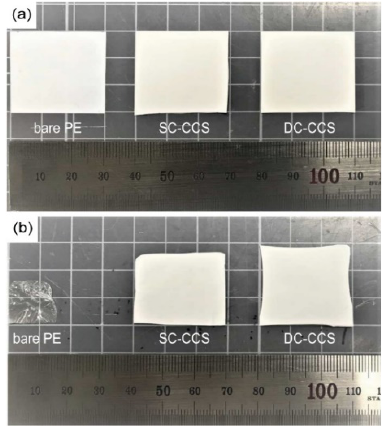
Figure 6. Digital camera images of bare PE, SC-CCSs, and DC-CCSs ( a ) before and ( b ) after exposure to 140 °C for 30 min.